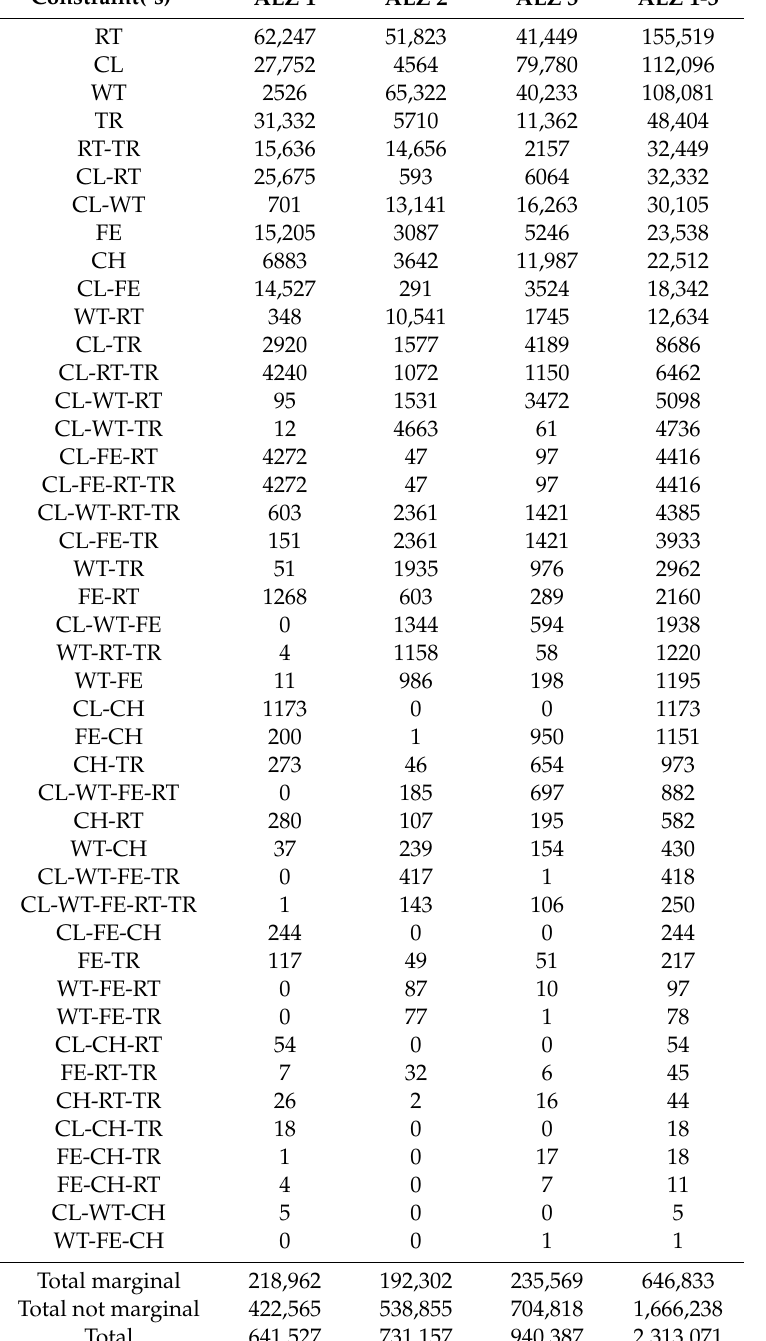
Table 2. Relevance of the constraints and constraint combinations expressed as agricultural area (km 2 ) per